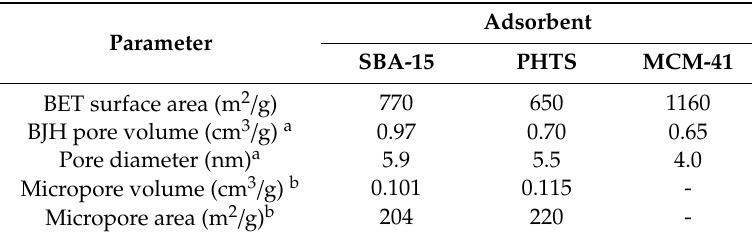
Table 1. Textural properties of nonmodified mesoporous materials.